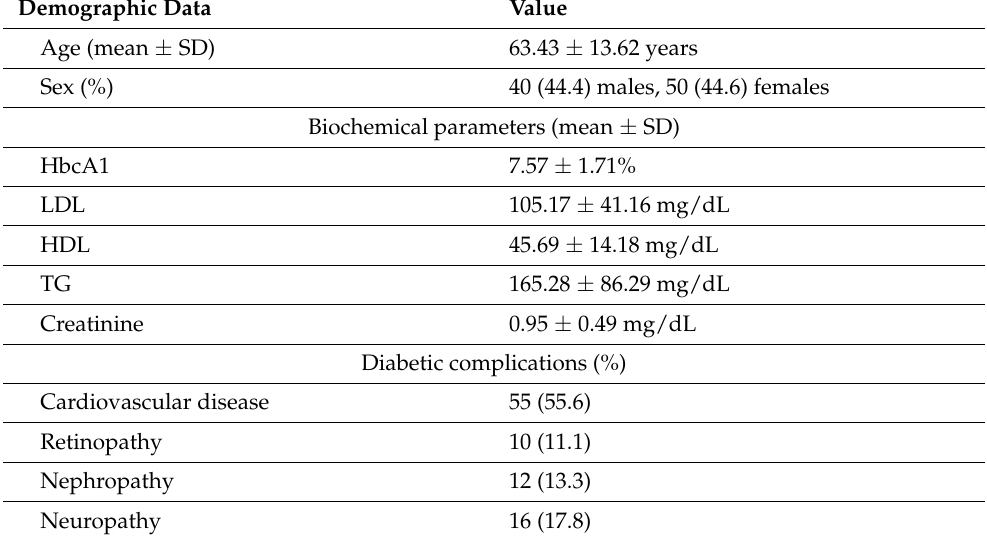
Table 2. Demographic and clinical data of the diabetic